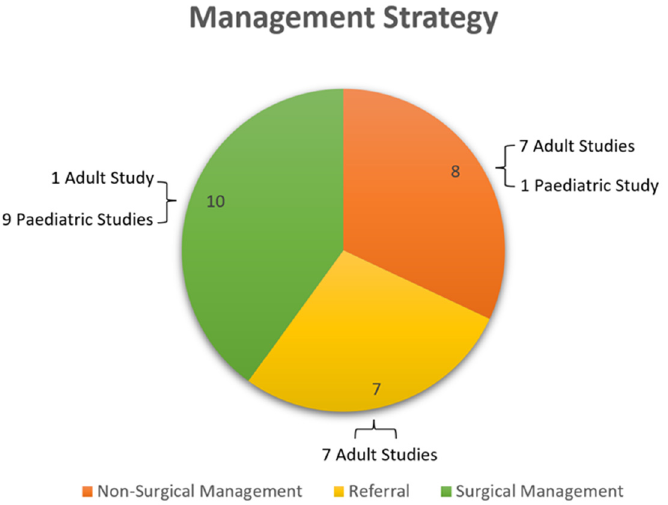
Figure 3. Pie chart illustrating the number of included studies (further broken down into pediatric and adult studies) that focused on non-surgical management (orange), referral (yellow), and surgi- cal management (green) as a management strategy for keratoconus.